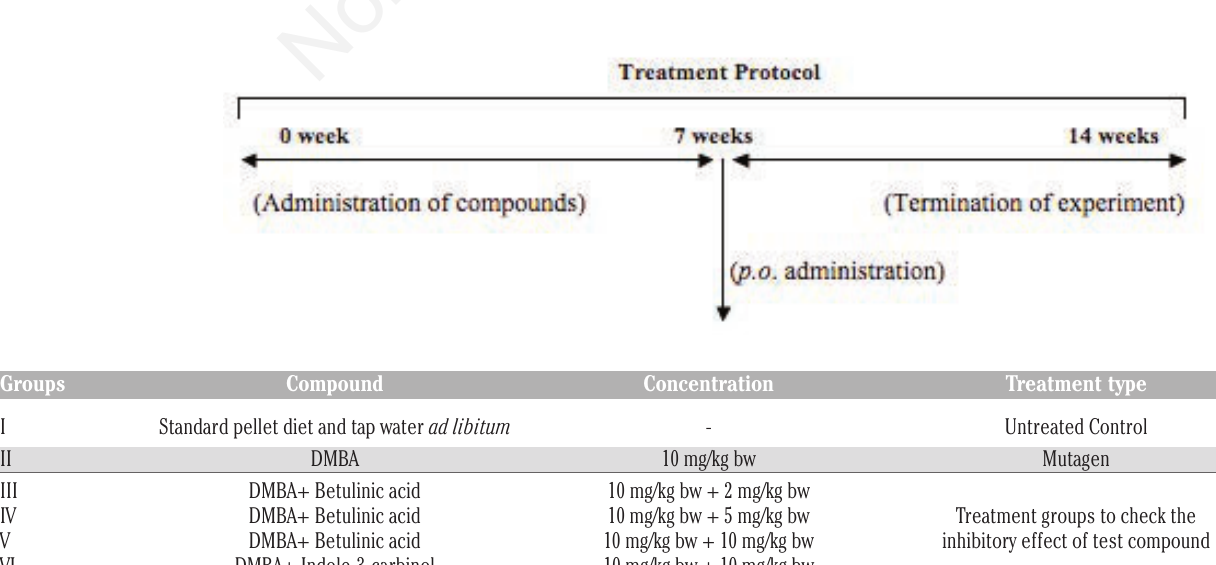
Table 1. The treatment protocol of Betulinic acid, DMBA and I3C among the Sprague Dawley female rats assorted in 6 groups (n=6 for each